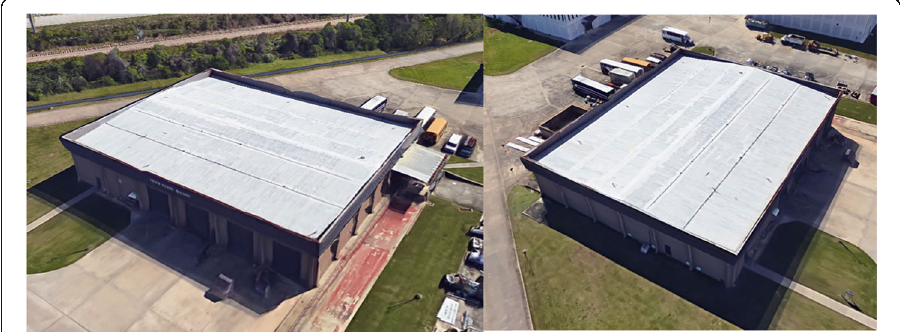
Fig. 5 A low-rise building with gable roof and perimeter parapet, Baton Rouge, Louisiana (Dimensions: 163 ft. × 130 ft. × 21.5